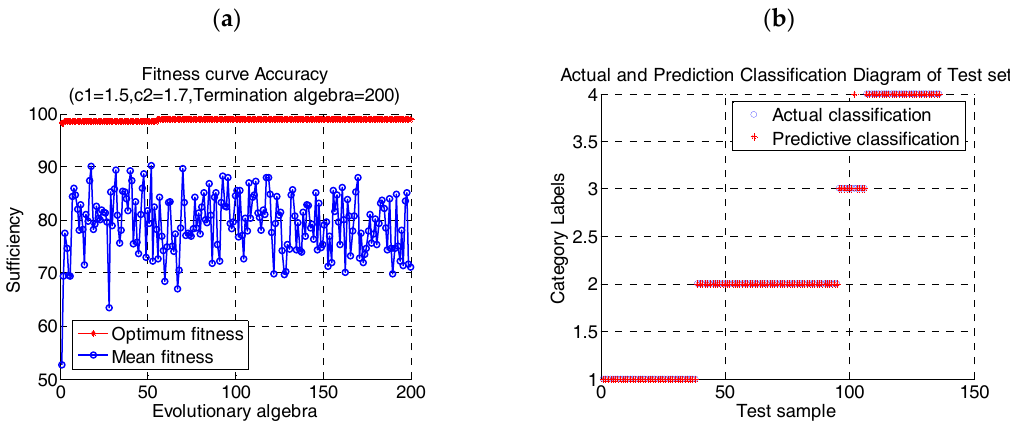
Figure 8. Clustering results of human peripheral blood cells ( a ) Fitness curve; ( b ) Clustering results.